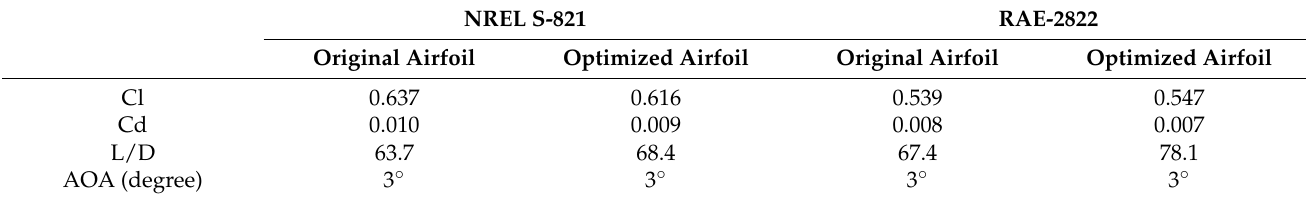
Table 5. Detailed XFOIL performance comparison of airfoils NREL S-821 and